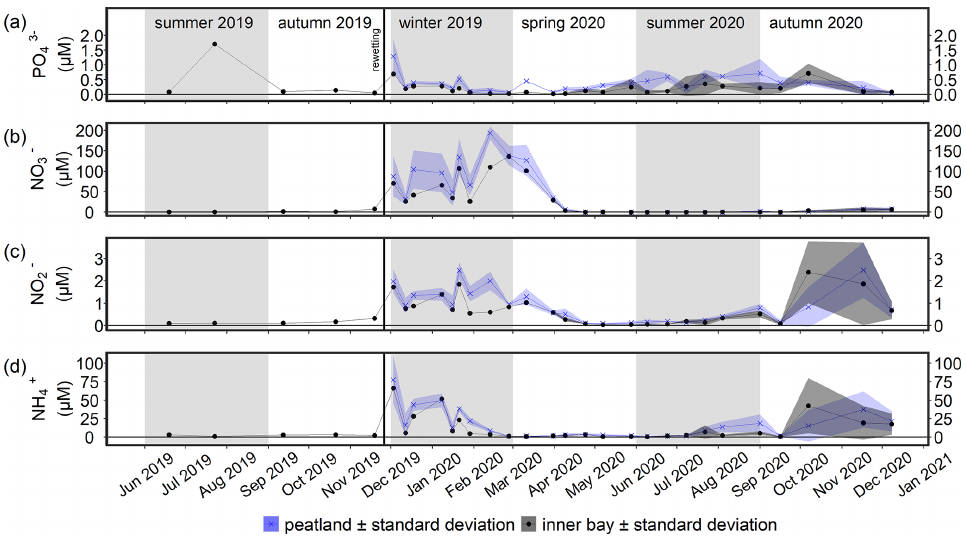
Figure 4. Time series of the mean (a) PO 3 − June 2019 to December 2020. Data from the flooded peatland ( n = 6) are shown in blue and data from the inner bay (until 11 March 2020, n = 1; thereafter, n = 2) in black. The vertical black line indicates the rewetting